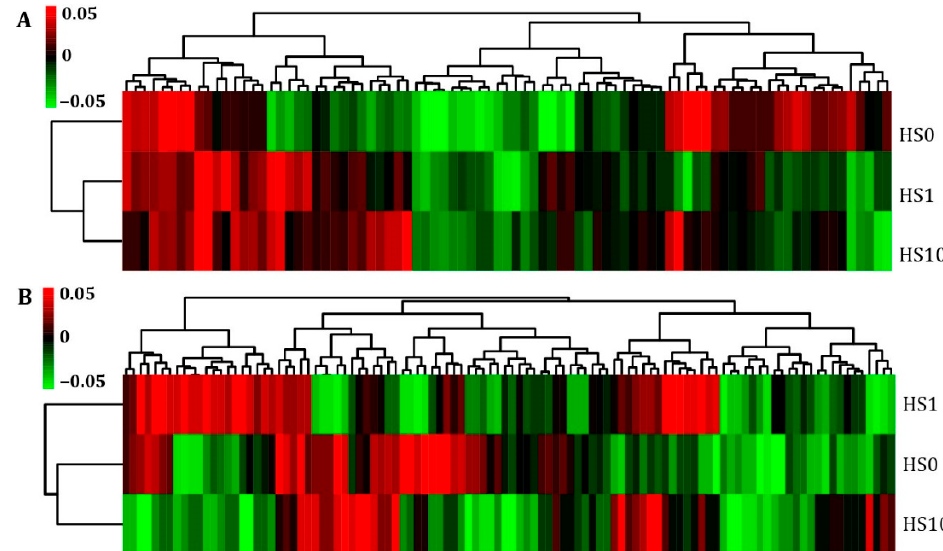
Figure 3. Clustering of the functional gene abundances under different humic substance conditions based on the functional annotation of the genes by ( A ) COG and ( B ) KEGG pathways. HS0, HS1 and HS10 indicate 0, 1 and 10 mg·L − 1 humic substances, respectively.